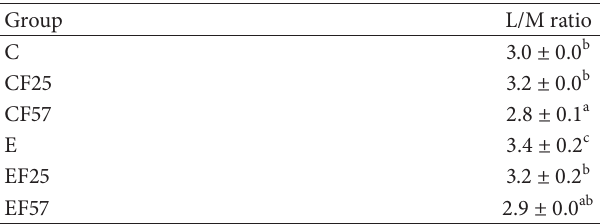
Table 8: Effects of fish oil on the lactulose/mannitol (L/M) ratio in rats under chronic ethanol feeding 1,2